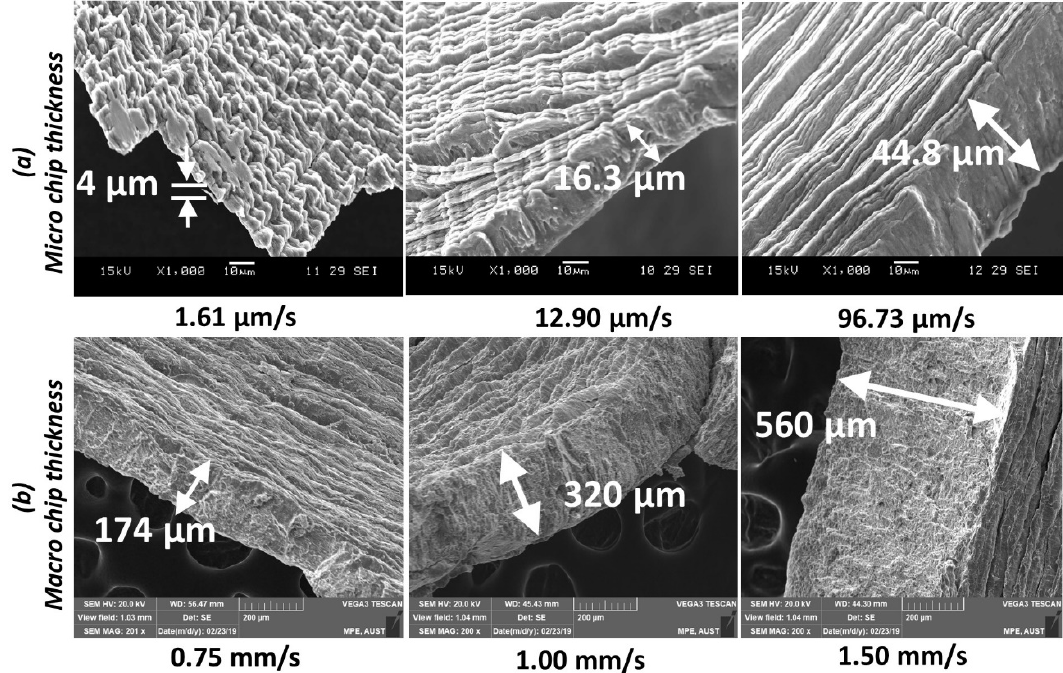
Figure 13. Measurement of deformed chip thickness ( h o ) of Al alloy with varying feed rate ( f ) for ( a ) micro machining ( b ) macro machining.